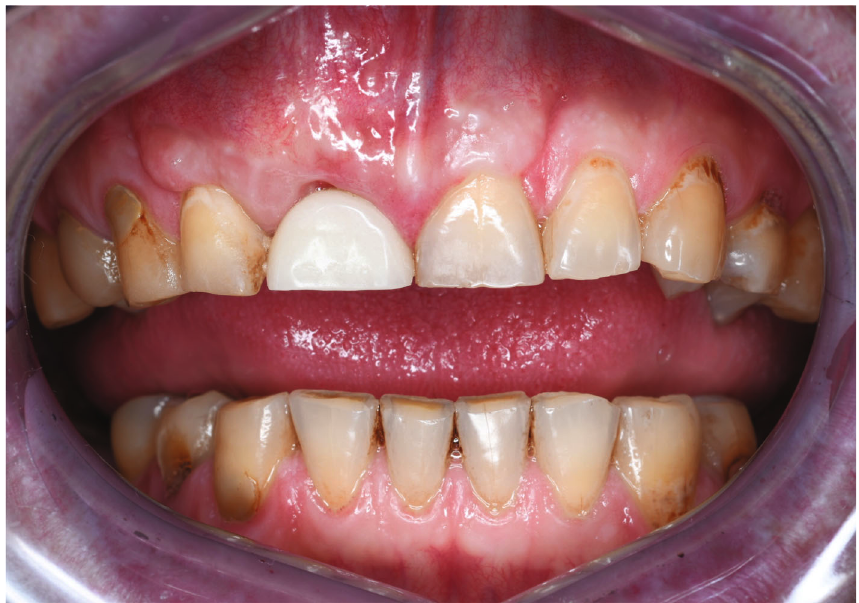
Figure 13: One-month